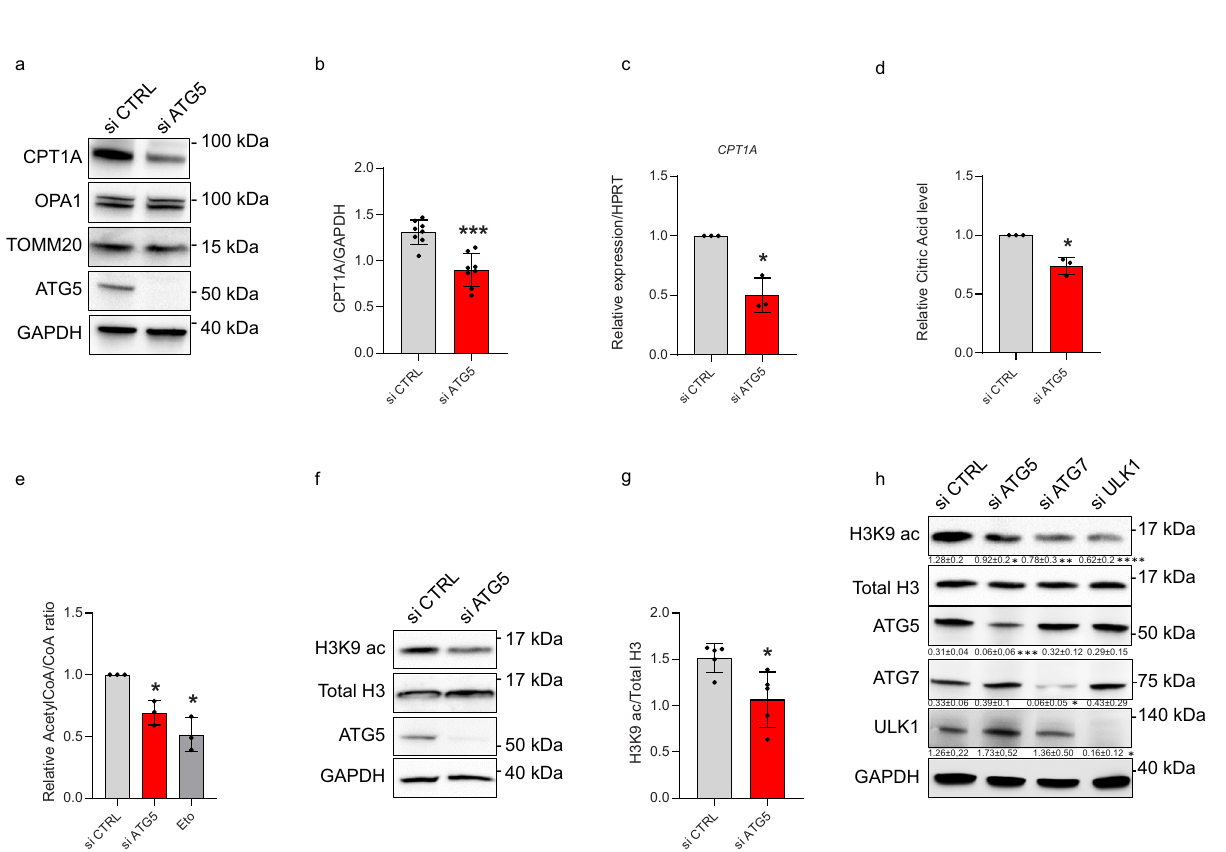
Fig. 4 LEC-autophagy is required for the traf fi c and release of lipids for mitochondria fatty acid oxidation. Representative super resolution AiryScan live images ( a ) and quanti fi cation of colocalization of fl uorescently labeled (C16:0) palmitate (BODIPY-PAL) in combination with NILE RED (Manders M1 coef fi cient) ( b ) and quanti fi cation of lipid droplets ( c ) in si CTRL and si ATG5 LEC pulsed with BODIPY-PAL (overnight incubation) and imaged at 0 h and after 24 h chase period. Zoomed boxed areas show BODIPY-PAL (green) colocalization with NILE RED-stained lipid droplets (magenta). Mean ± SD, N = 3 biological replicates with a minimum of 19 cells per condition in total analyzed using one-way ANOVA with Tukey ’ s test for multiple comparisons ( b ) and Kruskal – Wallis test with Dunn ’ s multiple comparisons test ( c ), ** p < 0.01, *** p < 0.001 and **** p < 0.0001 vs si CTRL (0 h). Scale bars represent 10 μ m. d – j Representative super resolution AiryScan live images ( d ) of si CTRL and si ATG5 LEC pulsed with BODIPY-PAL (overnight incubation) and imaged after 6 h and 24 h chase period. Mitochondria were labeled with MitoTracker deep red (30 min), before imaging ( e , h ), mitochondrial circularity ( f , i ), and index of mitochondrial fragmentation (number of mitochondria/ total mitochondrial area) ( g , j ). Zoomed boxed areas show colocalization of the mitochondria (magenta) with BODIPY-PAL-signals (green). Mean ± SD, N = 3 biological replicates with a minimum of 23 cells per condition in total analyzed using unpaired two-tailed Student ’ s t test ( e , f , h ) or two-tailed Mann-Whitney test ( g , i , j ), ** p < 0.01 and **** p < 0.0001 vs si CTRL. Scale bars represent 10 μ m. k Oxygen consumption rate (OCR) of LEC isolated from WT or LEC-Atg5 − / − mice. l ATP-linked respiration. m Maximal respiration and n Spare respiratory capacity from ( k ). Mean ± SD, N = 3 biological respiration using unpaired Student ’ s t test (two-tailed), **** p < 0.0001. o OCR of si CTRL or si ATG5 LEC measured in ß-oxidation assay medium. Etomoxir (Eto, 40 μ M) was added 15 min prior to baseline measurement in ß-oxidation assay medium. p Maximal respiration and q Spare respiratory capacity from OCR in ( o ). Mean ± SD, N = 4 biological replicates analyzed using one-way ANOVA with Tukey ’ s test for multiple comparisons, * p < 0.05 and ** p < 0.01 vs si CTRL. r Fatty acid oxidation (FAO) assay of si CTRL and si ATG5 LEC supplemented with 2 mCi/mL [9,10-3H]-palmitic acid for 18 h. Mean ± SD, N = 4 biological replicates analyzed using one sample t test (two-tailed), ** p = 0.003.